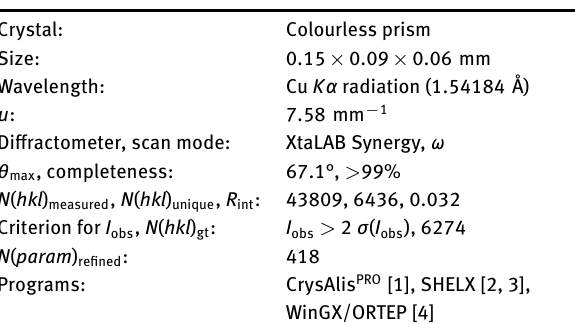
Table 1: Data collection and handling.